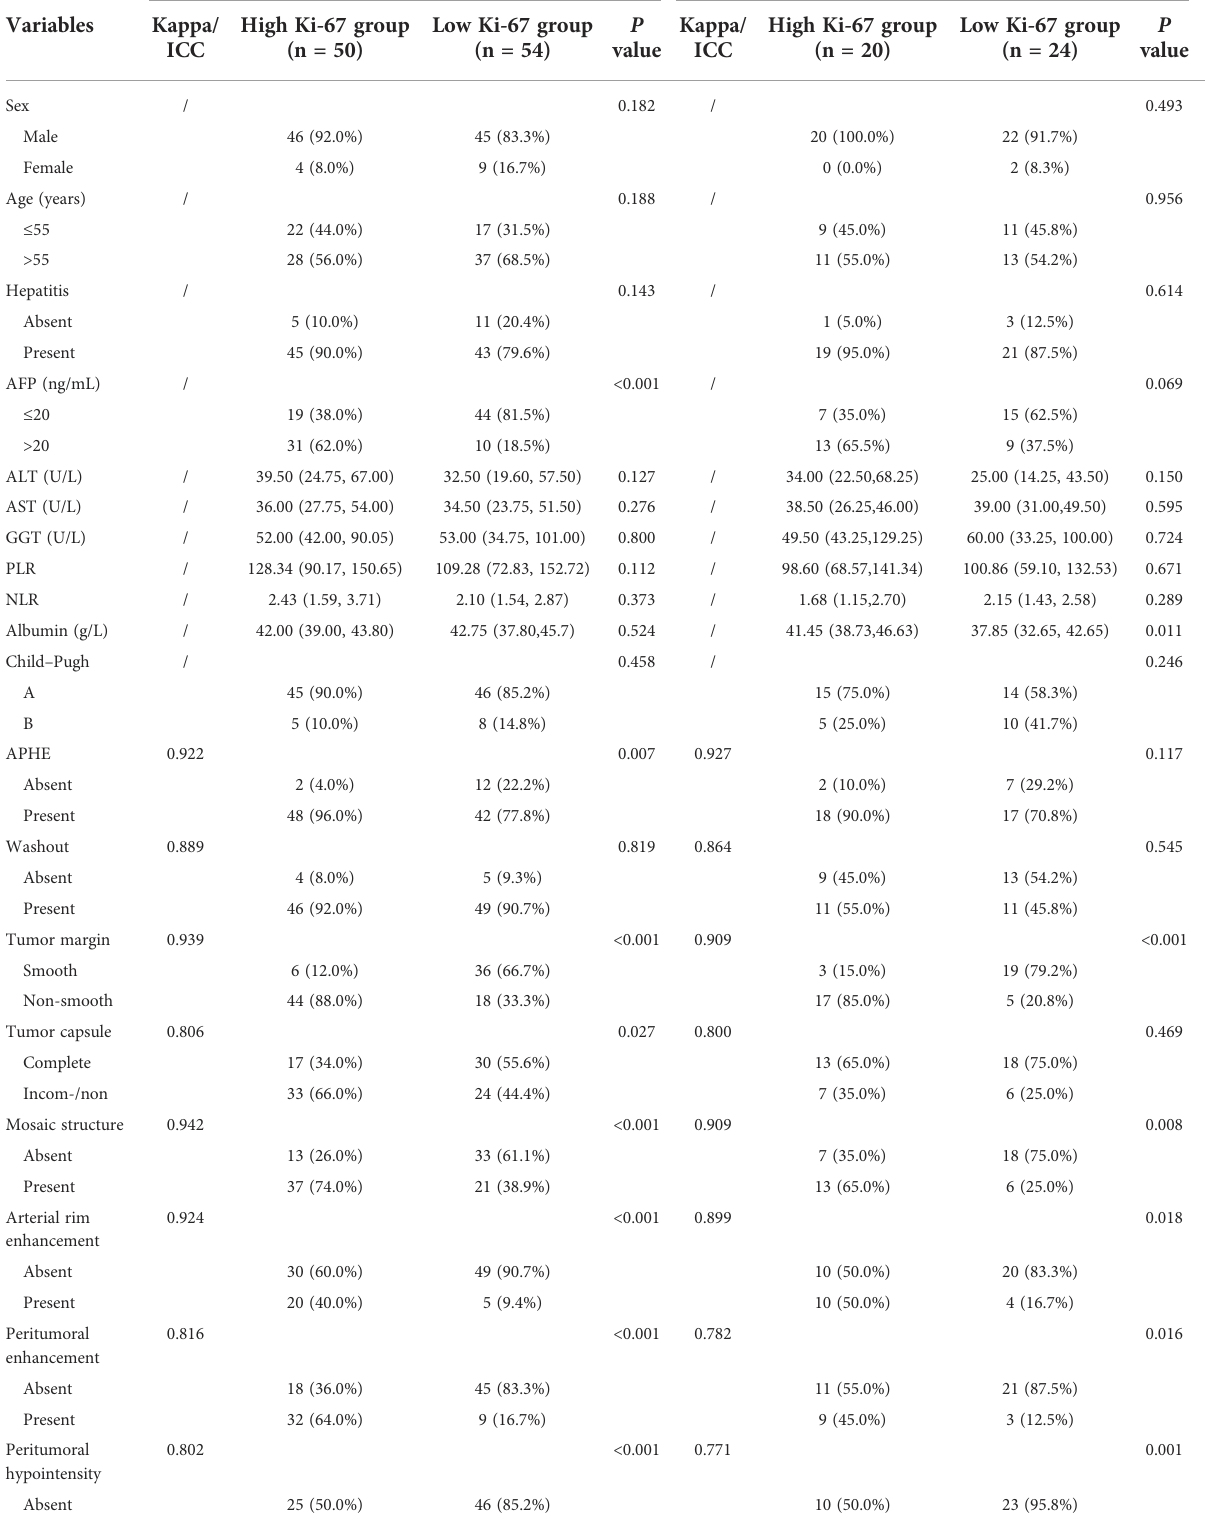
TABLE 3 Baseline characteristics of patients in the Ki-67 high and low expression